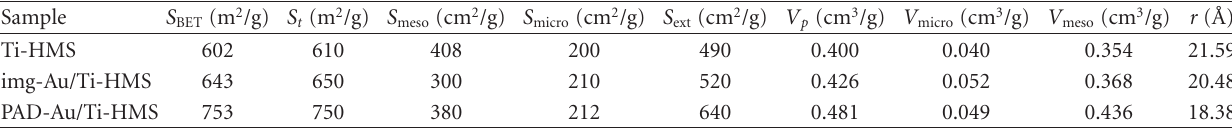
Table 1: Texture parameters of Ti-HM, img-Au/Ti-HMS and PAD-Au/Ti-HMS. Sample